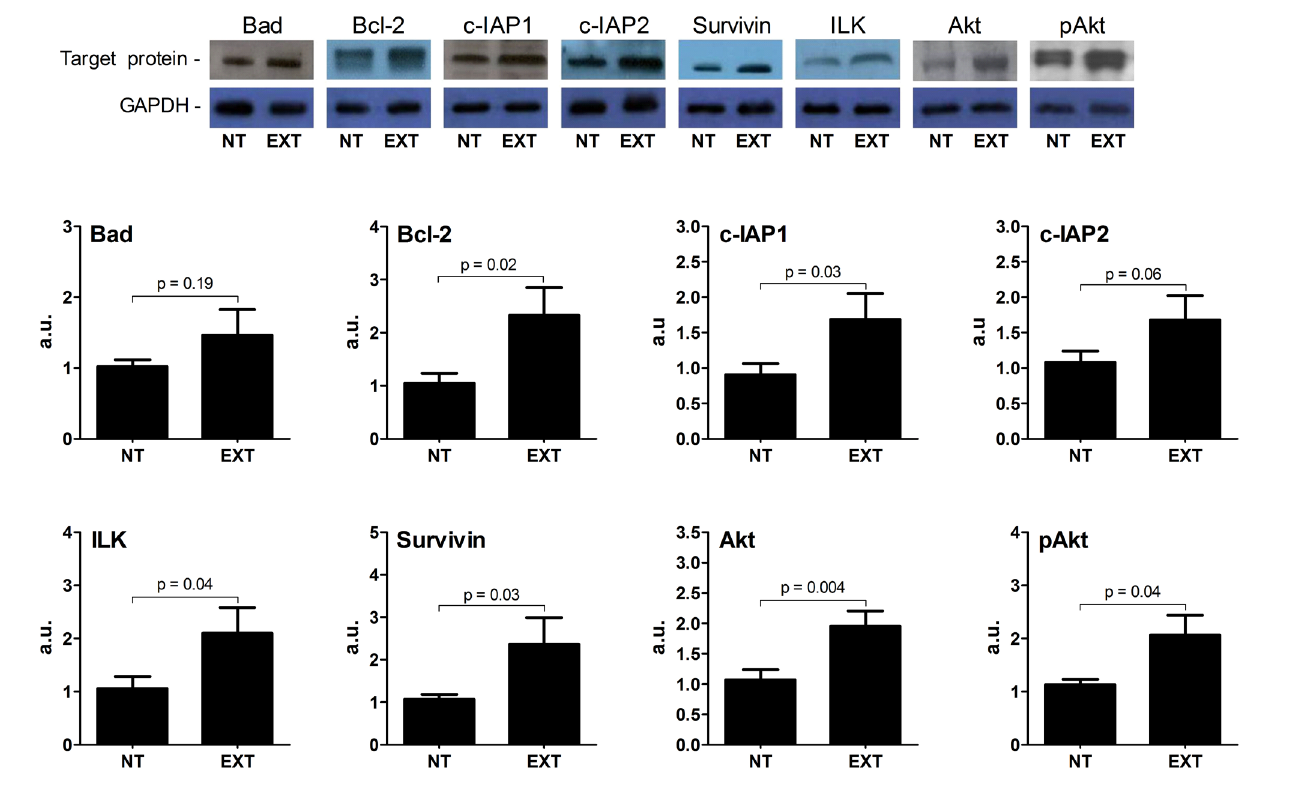
Figure 1. The protein expression for pro- (Bad) and anti (Bcl-2, c-IAP1, c-IAP2, ILK, Survivin, Akt and pAkt) - apoptotic factors by Western blot in myocardium. The upper panel is a representative Western blot for target proteins. All values were normalized for levels of GAPDH. The specific data for each protein are shown in lower